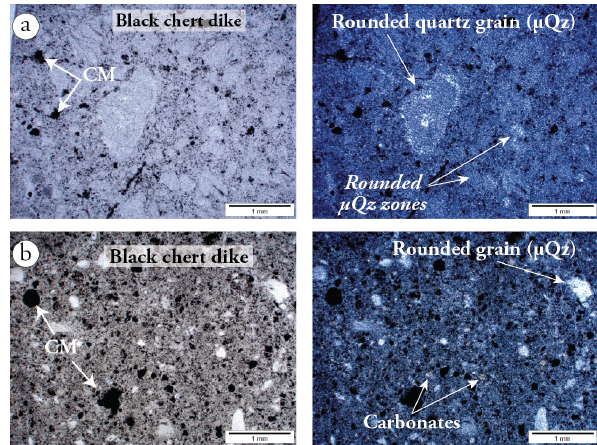
Figure 9. Photomicrographs of fracture-filling black chert sam- ples. Left column is normal light and right column is polarized light. CM = carbonaceous matter; mQz = microquartz. (a) Sample 1 composed of rounded particles of silica and carbonaceous matter in a matrix of microquartz. The grains are 100–200mm on aver- age. Silica grains are composed of microquartz similar to the sur- rounding matrix leading to diffusive contact between both phases. Carbonaceous grains are aggregates of smaller particles. (b) Sam- ple 2 composed of rounded particles of silica (50% of the particu- late fraction), carbonaceous matter (50%) and carbonate (<2%) in a matrix of microquartz (up to 50–60% of the